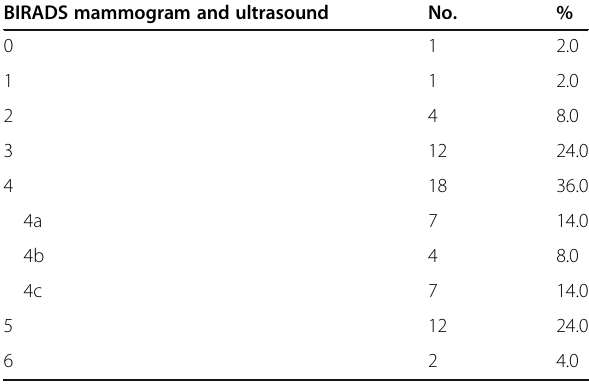
Table 1 Distribution of the studied cases according to BIRADS based on mammogram and/or ultrasound ( N = 50) BIRADS mammogram and ultrasound